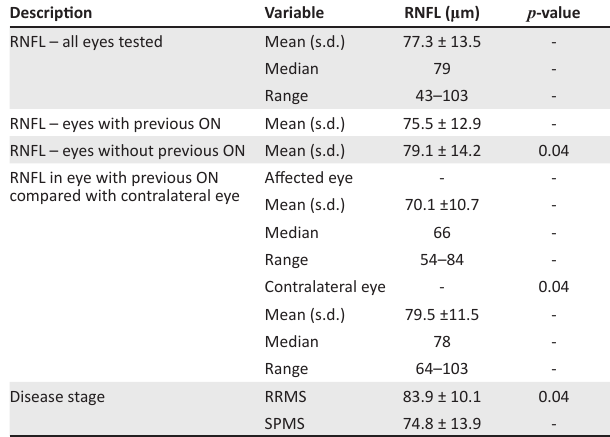
TABLE 3: Retinal nerve fibre layer thickness and changes with optic neuritis and disease stage as measured by optical coherence tomography in patients with multiple sclerosis.